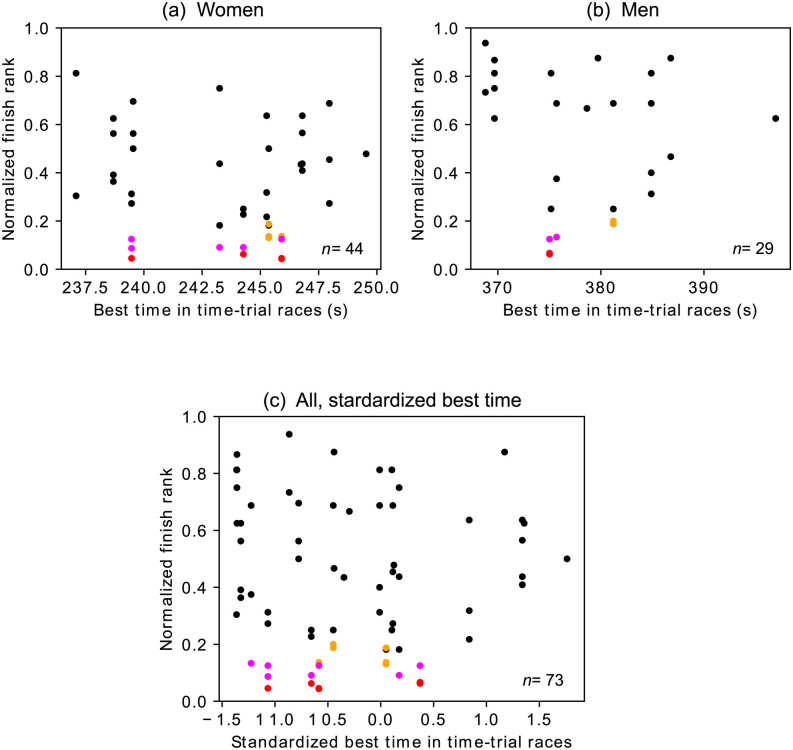
Relationships between the normalized finish rank and the best time in time-trial races.A circle represents a skater. The top three skaters in mass start races are shown in red, magenta, and orange. (a) Women. (b) Men. (c) Both sexes combined using the standardized best finish time.